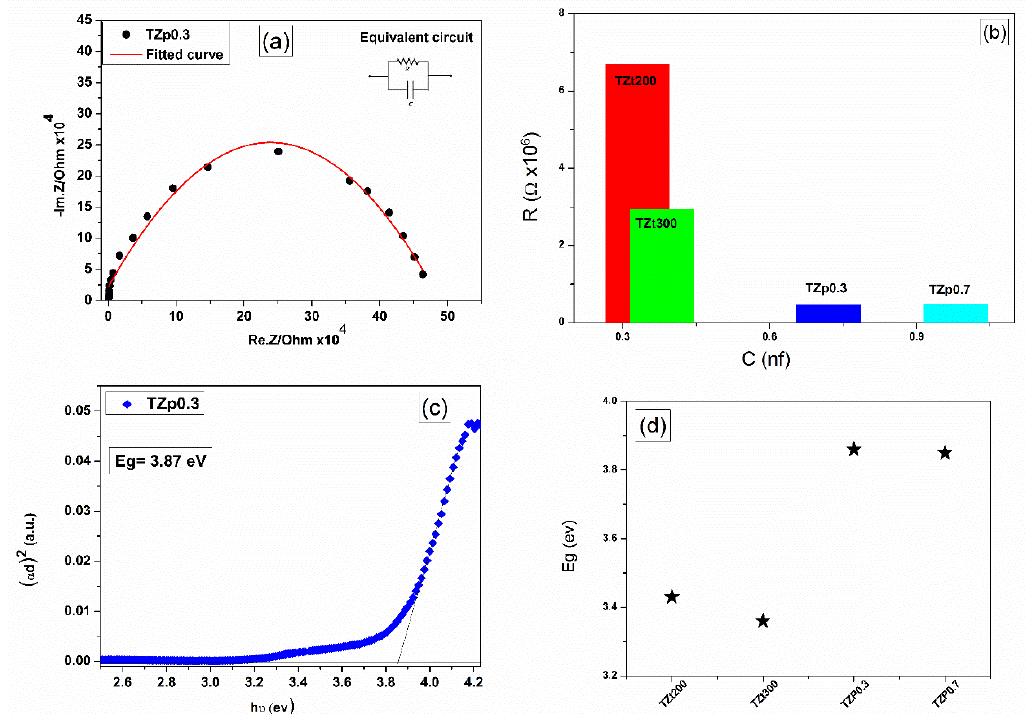
Figure 6. ( a ) Nyquist plot for the Ti-doped ZnO film after MwPA at 0.3 mbar with inset indication of the equivalent circuit model. ( b ) Resistance vs. capacity map for the different samples as extracted by fitting Nyquist plots to the equivalent circuit model. ( c ) Tauc plot for Ti-doped ZnO thin film after MwPA at 0.3 mbar. ( d ) Chart comparing the energy gap of the TA and MwPA films.